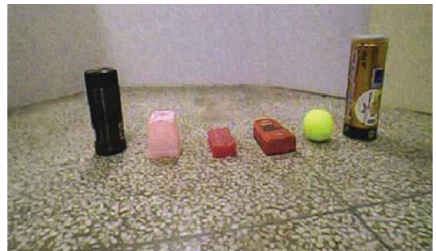
Figure 4: Experimental object.